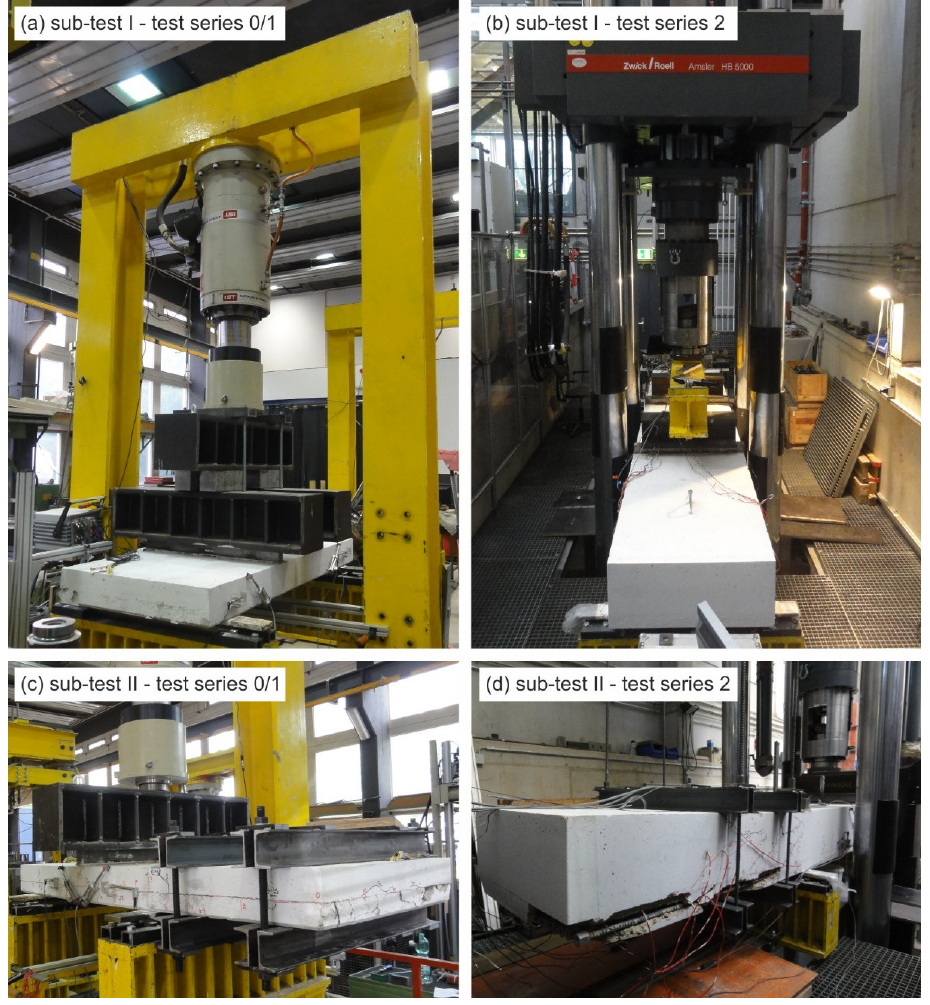
Figure 15. Test setup for fatigue tests: Sub-Test I for Test Series 0/1 ( a ), Sub-Test I for Test Series 2 ( b ), Sub-Test II for Test Series 0/1 ( c ), and Sub-Test II for Test Series 2 ( d